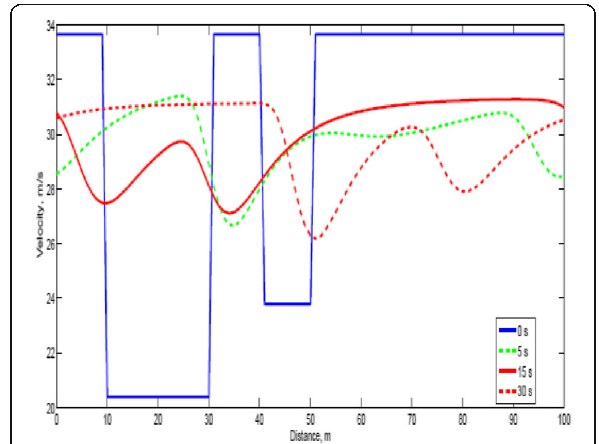
Fig. 6 The proposed model velocity behavior with b =